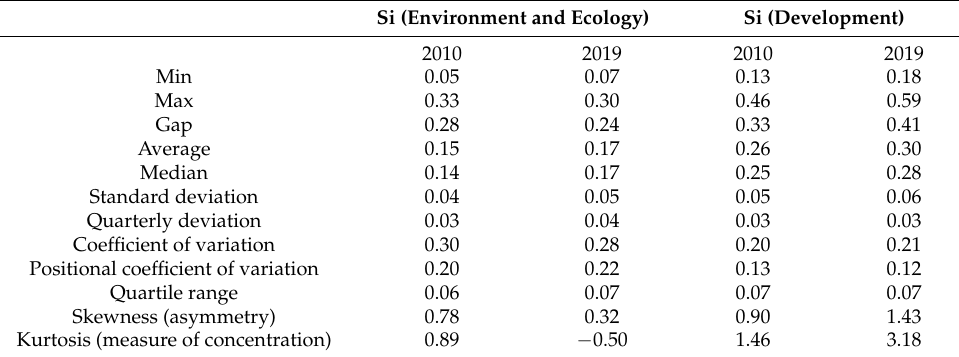
Table 4. Statistical characteristics of the synthetic measure of the financial situation as well as demography and the labor market of poviats in Poland in 2010 and 2019. Si (Environment and Ecology) Si